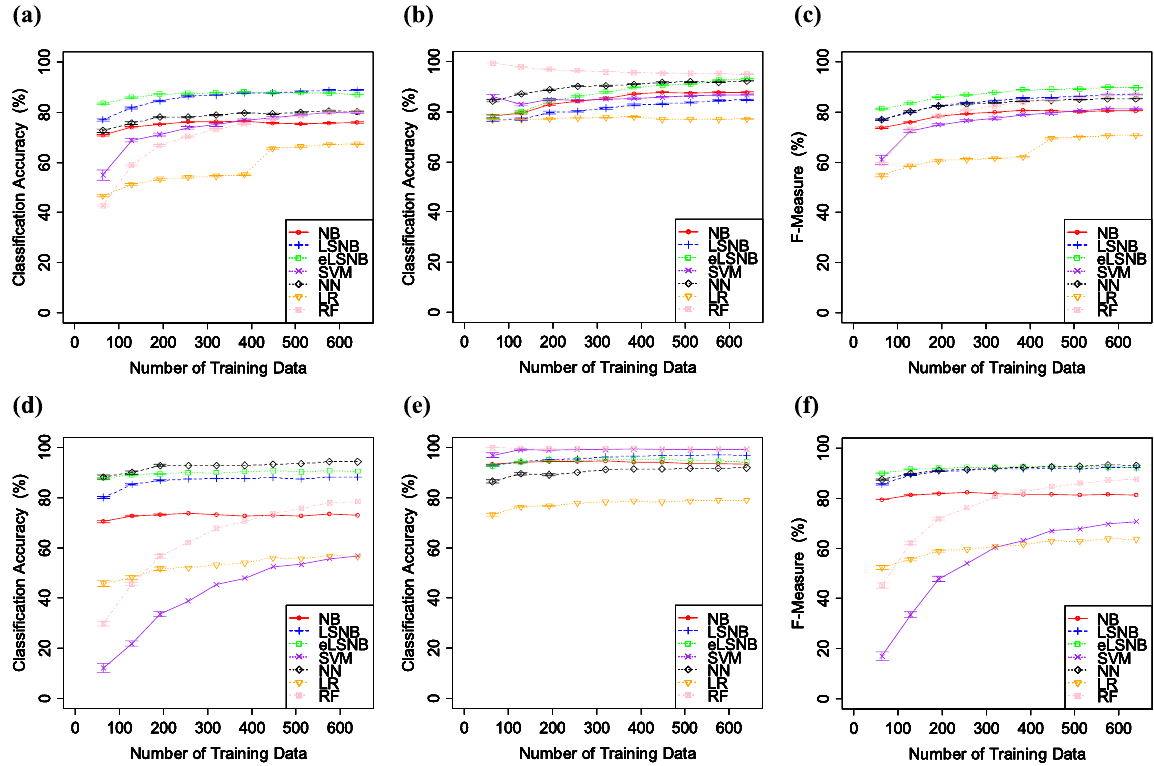
Figure 3. ( a ) spam classification accuracy, ( b ) ham classification accuracy and ( c ) f-measure values for spamassassin. ( d ) spam classification accuracy ( e ) ham classification accuracy and ( f ) f-measure values for ling- spam. Error bars indicate the standard